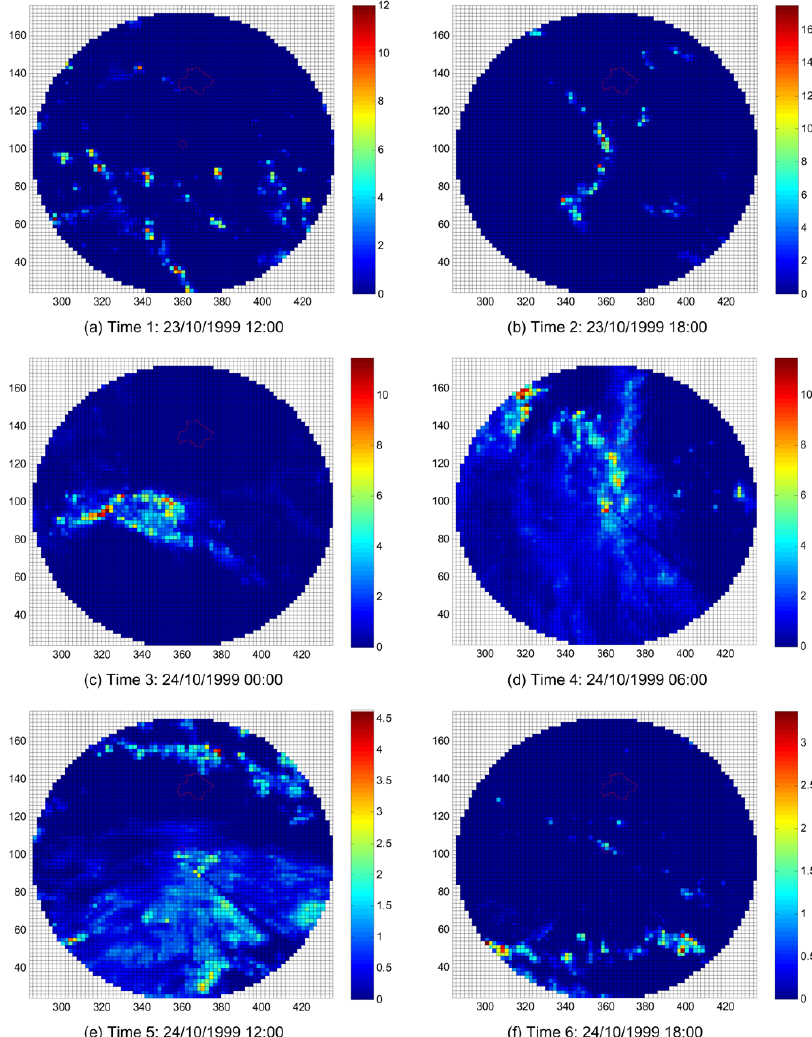
Fig. 3. Radar images of the lowest scan (0.5 ◦ ) on the 2km Cartesian grid at the six data-assimilation times of the storm event